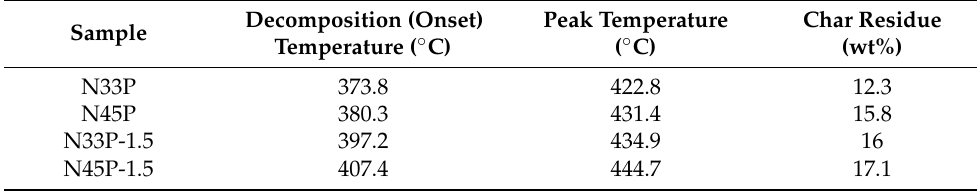
Table 5. Thermal decomposition properties of the blends and